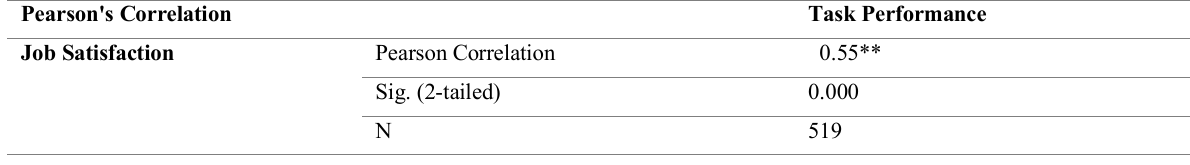
Table 10: Pearson’s Correlation conducted to test the relationship between job satisfaction and task performance Pearson's Correlation Task Performance Job Satisfaction Pearson